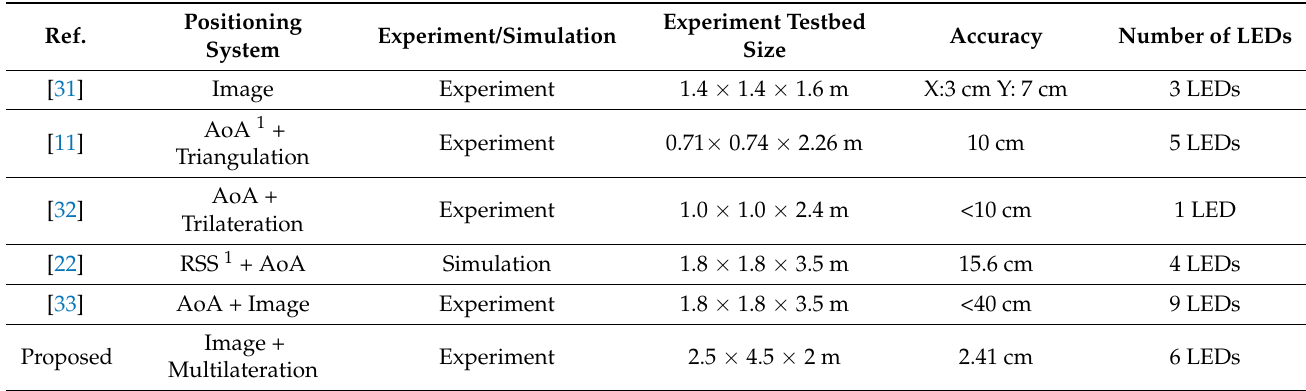
Table 3. Comparison of the proposed system with other VLC- and image sensor-based positioning systems.